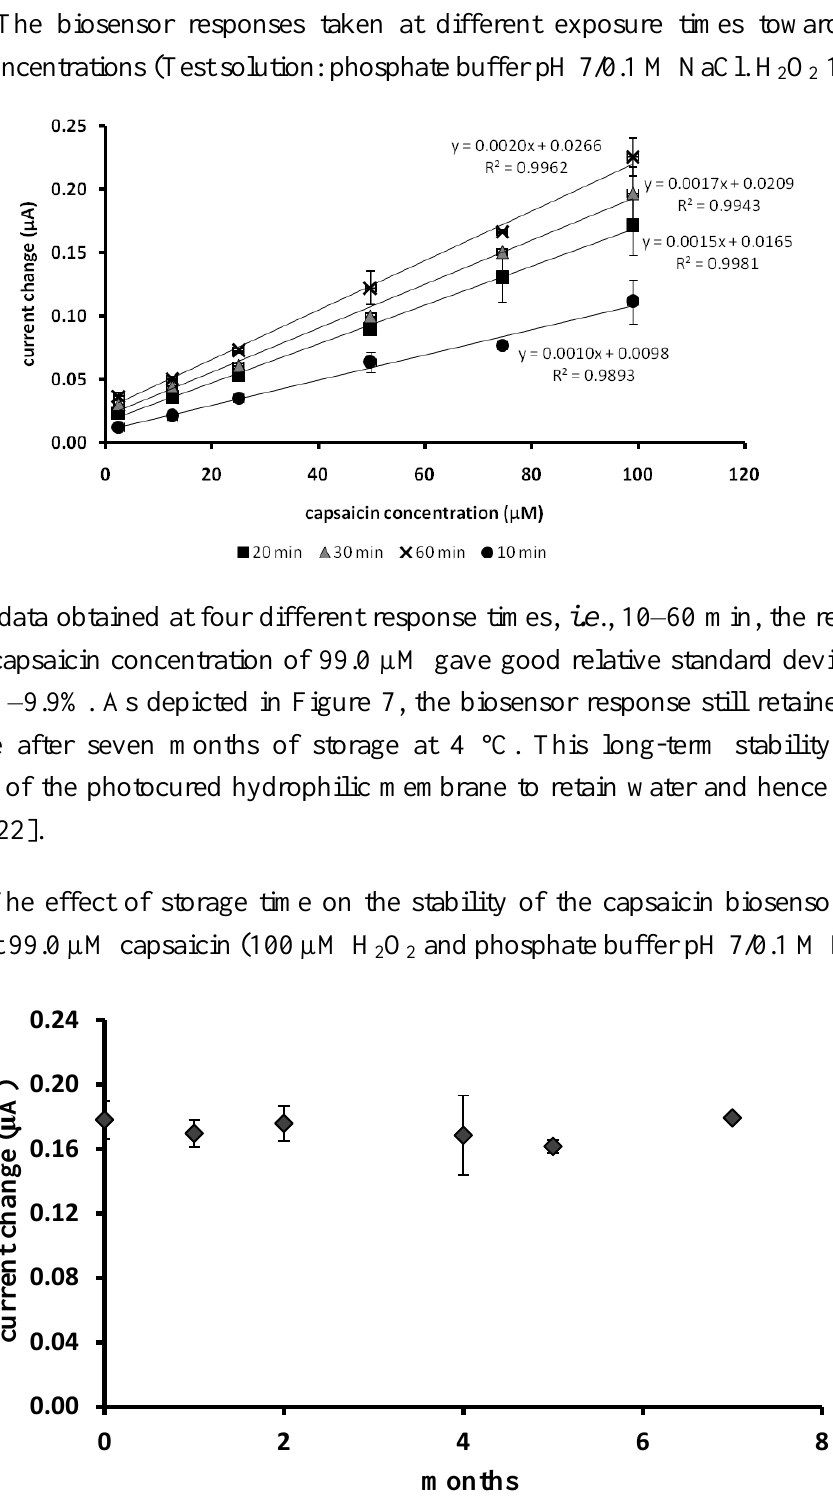
Figure 6. The biosensor responses taken at different exposure times towards various